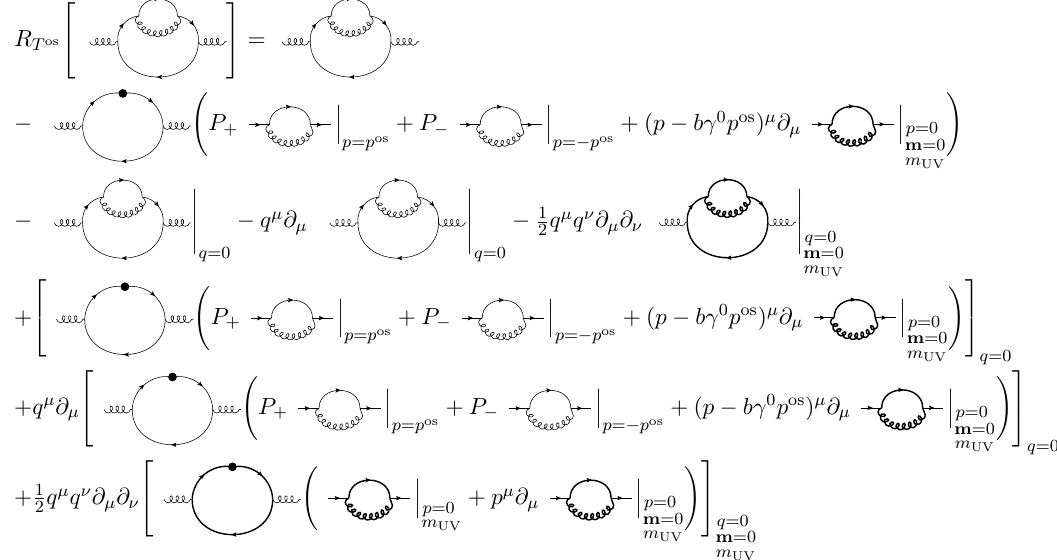
Figure 10. On-shell/soft subtraction for a massive quark self-energy nested within a gluon self- energy connection, performed using the approximation operator T os . The four-momentum p (resp. q ) corresponds to the external momentum of the inner (resp. outter) self-energy diagram.